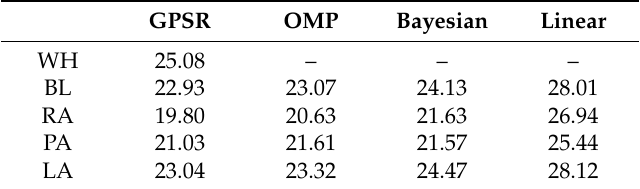
Table 7. Average PSNR values (dB) for different measurement structures using different recovery algorithms. GPSR OMP Bayesian WH –